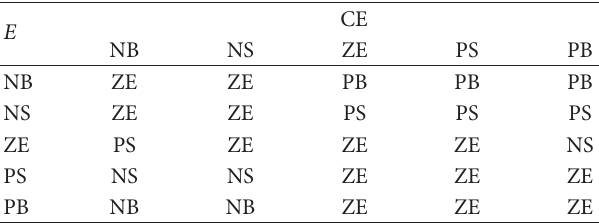
Table 2: The twenty-five fuzzy rules of the first fuzzy subset (S1).